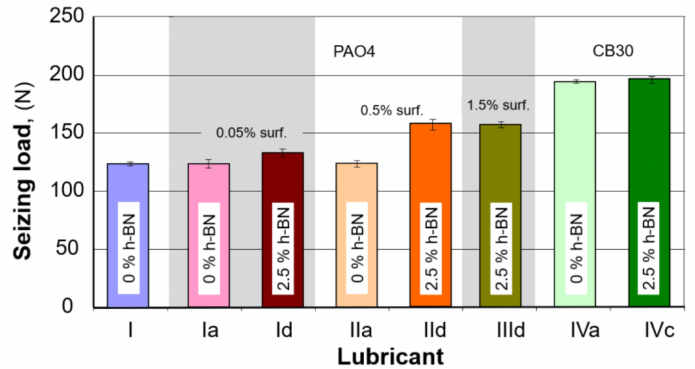
Figure 7. Seizure load values obtained.